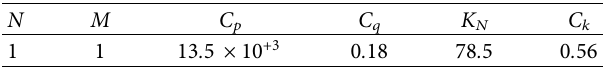
Linear Figure 8: Frequency response function of linear system (random excitation force 10.8N). Table 1: Identified parameters of the reference model [2] in the experimental model.